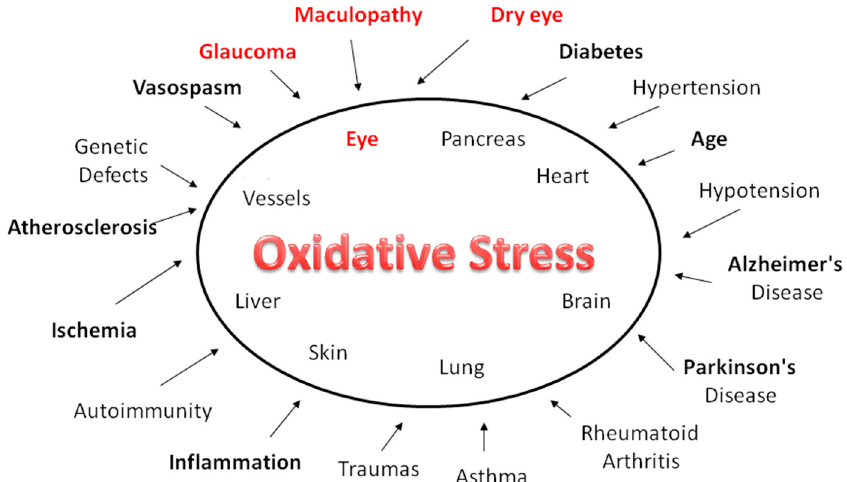
Figure 1. The human eye is constantly exposed to sunlight and artificial light. Exogenous sources of ROS, such as UV rays, visible light, ionizing radiations, chemotherapeutics, and environmental toxins, contribute to oxidative damage in the ocular tissues. In the long-term, such injuries expose the aged eye to considerable risk of the pathological consequences of oxidative stress. While this affects practically all organs and apparatuses, it has a heavy impact in diseases such as glaucoma, dry eye and age-related macular degeneration.